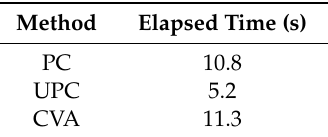
Table 1. The average elapsed time for identification of the dynamic model using di ff erent subspace